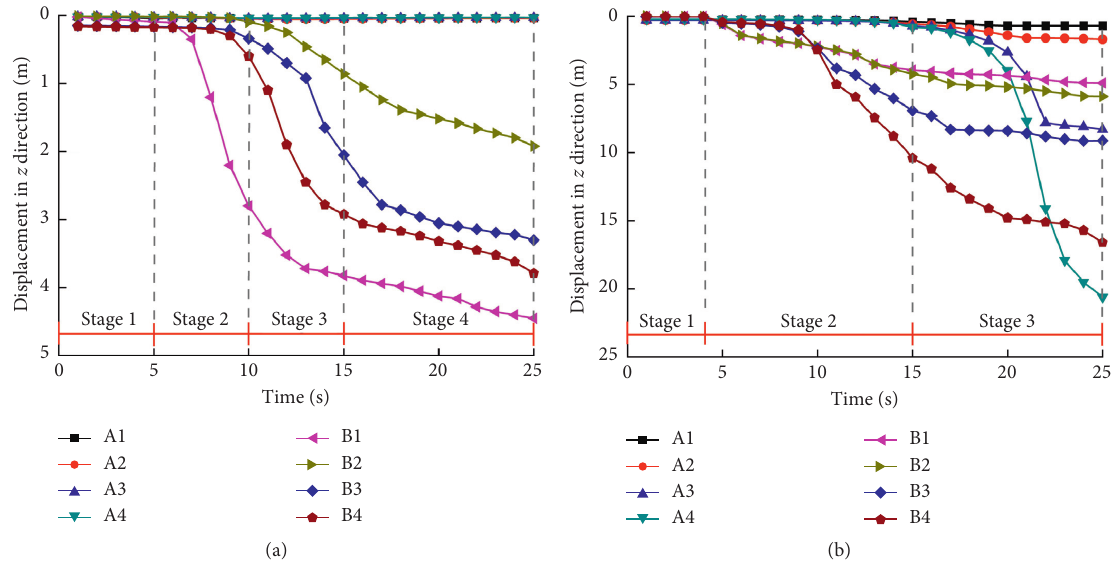
Figure 8: Displacement time-history curve of rock block in Z direction of Model 2 and Model 3. (a) Model 2. (b) Model 3.